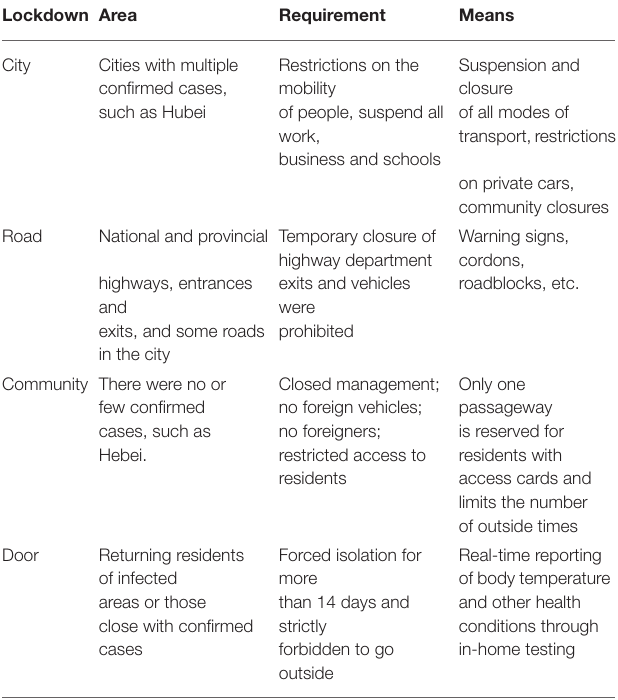
TABLE 2 | China’s lockdown